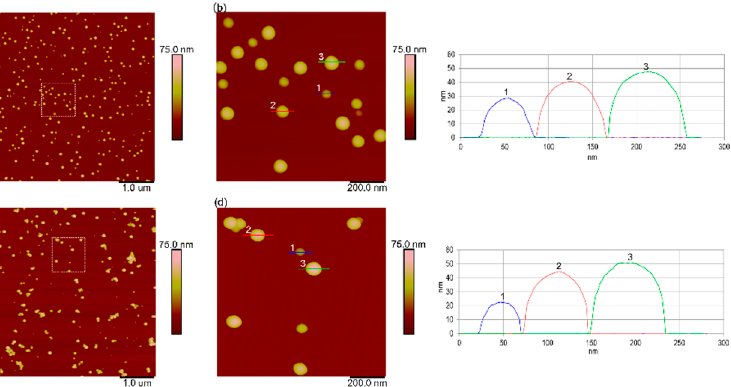
Figure 1. AFM characterization of amine-modified polystyrene nanoparticles (PS-NH 2 NPs) and carboxyl-modified polystyrene nanoparticles (PS-COOH NPs) in ultrapure water. AFM height images of PS-NH 2 ( a , b ) and PS-COOH nanoplastics ( c , d ) in ultrapure water (50 mg L − 1 ). The enlarged views of boxed areas in ( a ) and ( c ) are shown as ( b ) and ( d ), respectively. Vertical profiles of particles along indicated lines in ( b , d ) are shown next to the corresponding images (line crossing particle in AFM image and belonging vertical profile are shown in the same color and indicated by the same number). Images were acquired using the tapping mode in air, with scan sizes of 5 µm × 5 µm ( a , c ) and 1 µm × 1 µm ( b , d ), and a vertical scale of 75 nm.